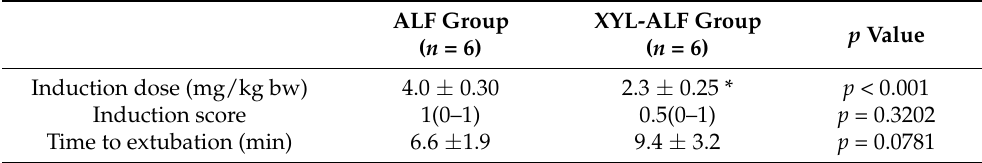
Data are expressed as the median and range (scores), mean ± SD (doses and times). * Significant difference between the two groups ( p <